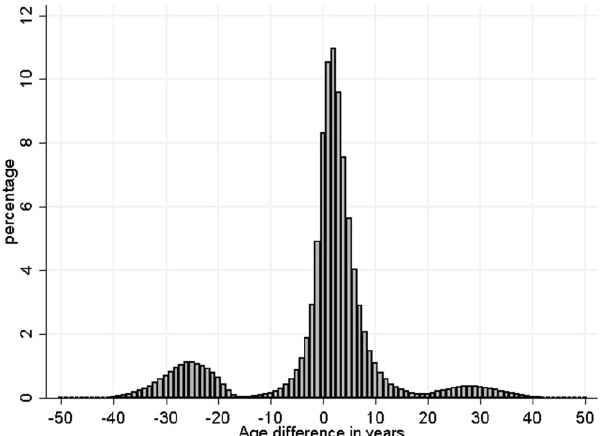
Fig. 1 Distribution of age differences of matches, male/female. (Note: Includes all male-female pairs of individuals who we were able to match by location and name (according to our name-matching algorithm). Age difference is calculated as man’s age – woman’s age)